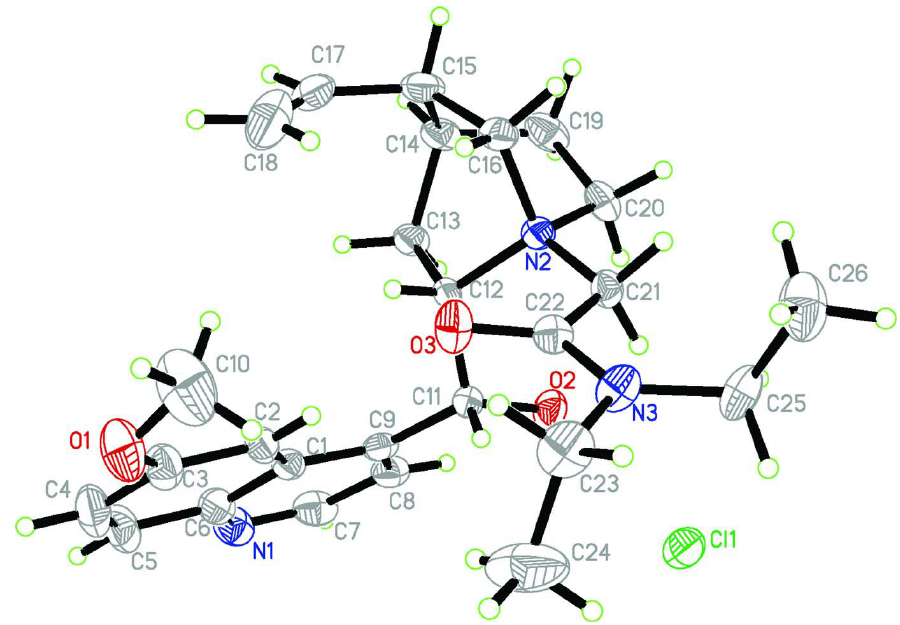
Figure 1 The asymmetric unit of the title compound, showing 30% probability displacement ellipsoids. Water molecule has been omitted for clarity.